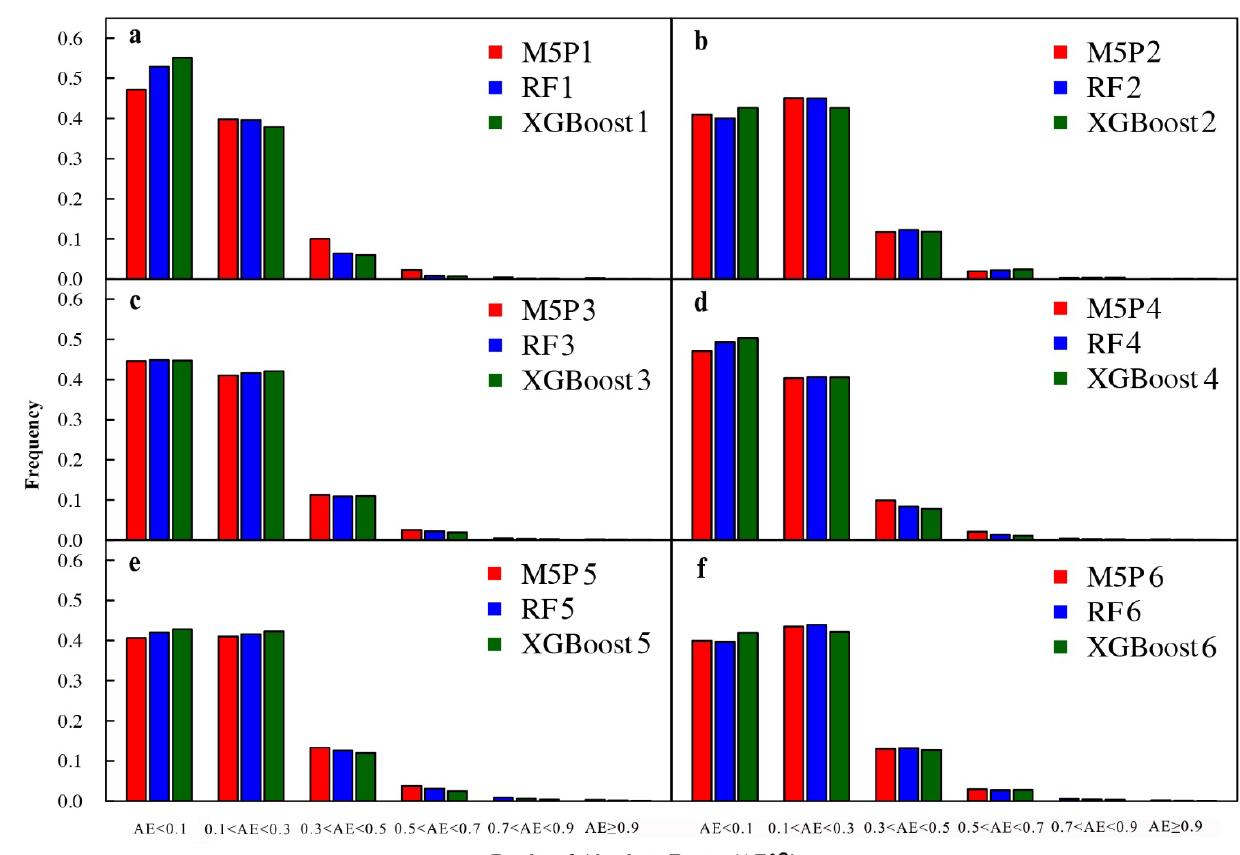
Figure 10. Frequency distribution of absolute errors (AE) between measured and estimated daily T s obtained by three machine learning models under various input combinations ( a – f ) during testing.